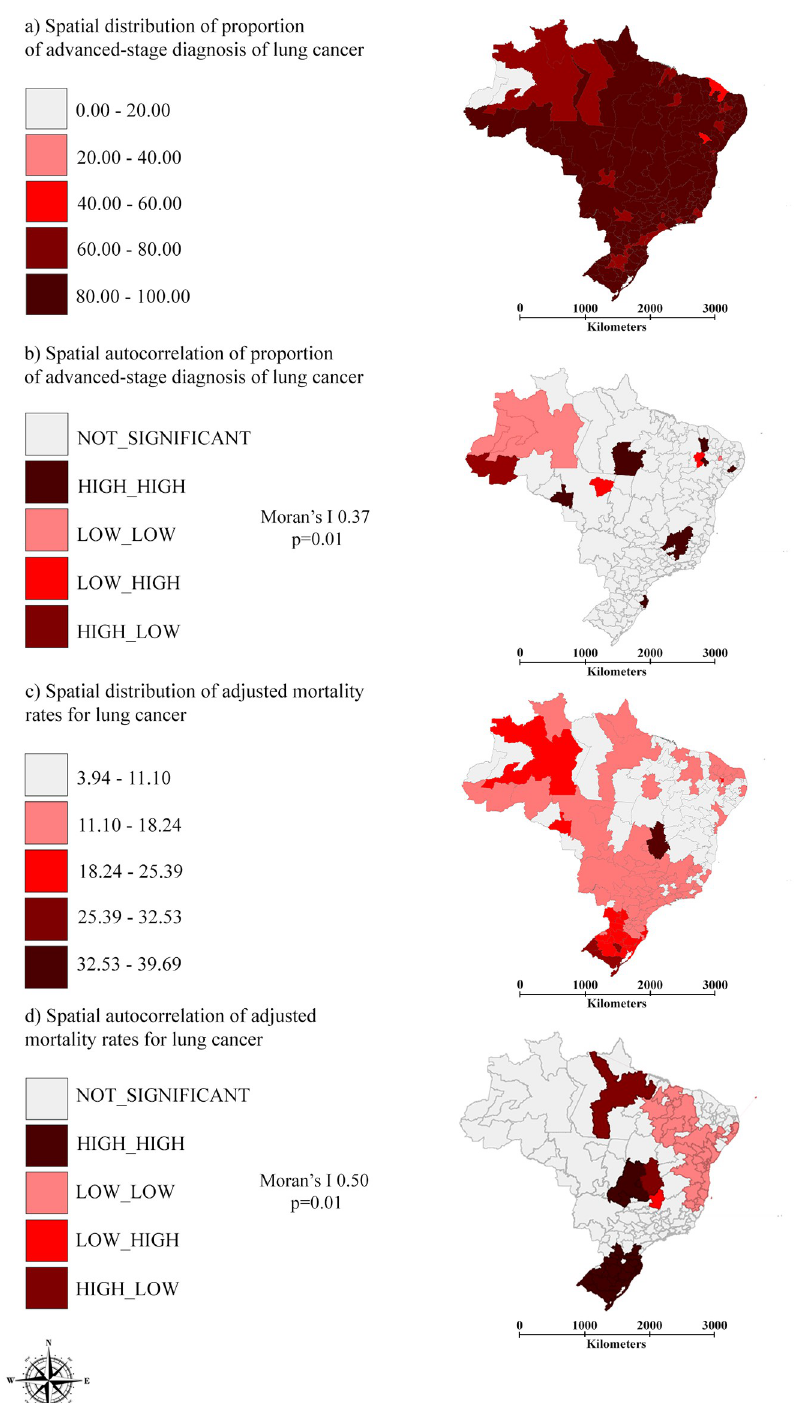
Fig 2. (a) Spatial distribution and (b) spatial autocorrelation of proportion of advanced-stage diagnosis, for both sexes, of lung cancer; (c) spatial distribution and (d) spatial autocorrelation of age-adjusted mortality rates for lung cancer, for both sexes per IRUA, Brazil,